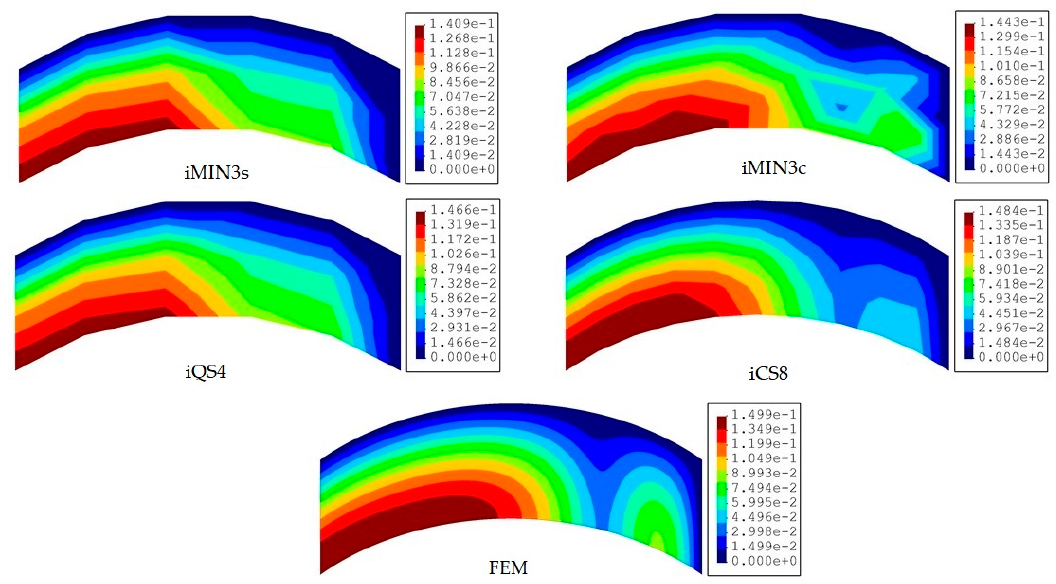
Figure 9. Contours of total displacement [mm] obtained from iFEM (moderate mesh) and high-fidelity FEM analyses for the curved plate.